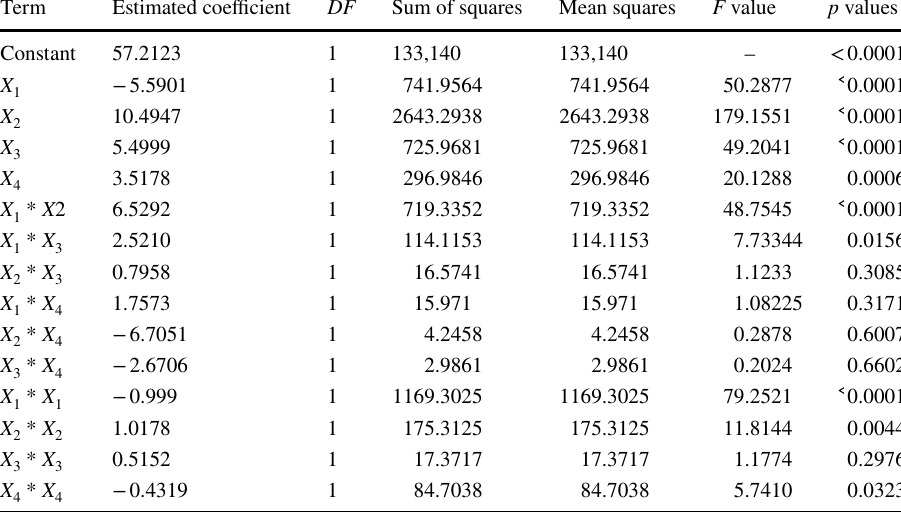
Table 3 Analysis of variance (ANOVA) of the factors on the